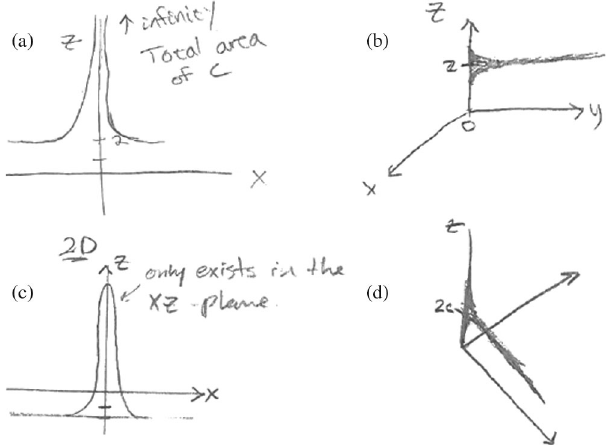
FIG. 1. Examples of the spike representation used by 5% of exam students and two of 11 interview students. In this case, students were prompted to sketch the charge distribution described by ρ ð x; y; z Þ ¼ c δ ð x Þ δ ð z − 2 Þ